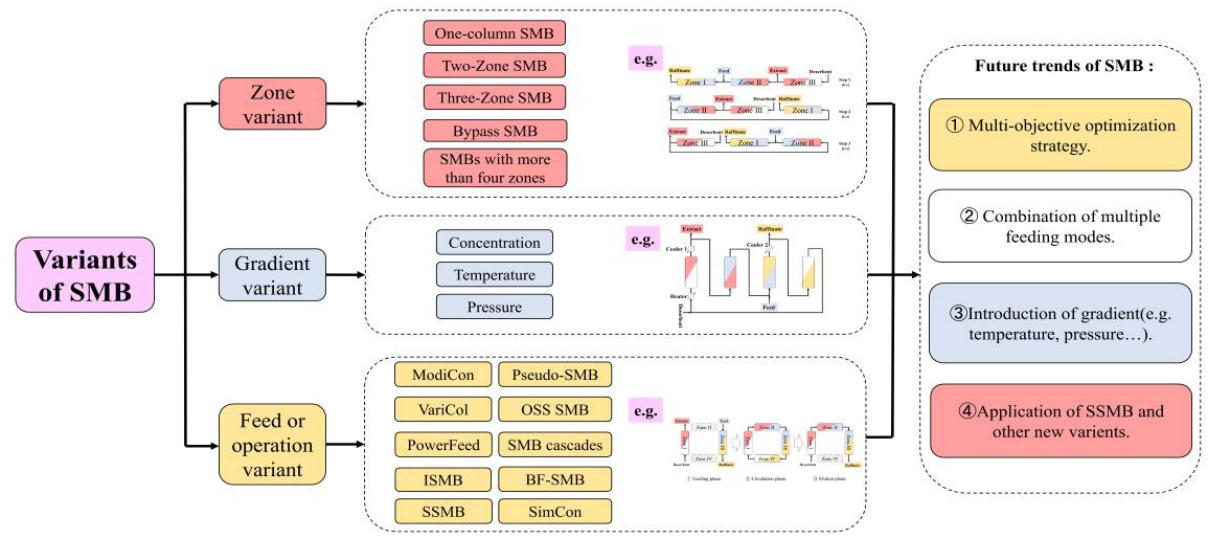
Figure 3. The framework structure of review.